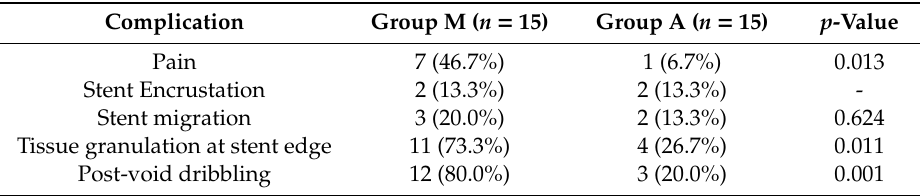
Figure 4. Mean maximal urinary flow rates (Qmax) after stent removal. Table 2. Stent-related complications in both